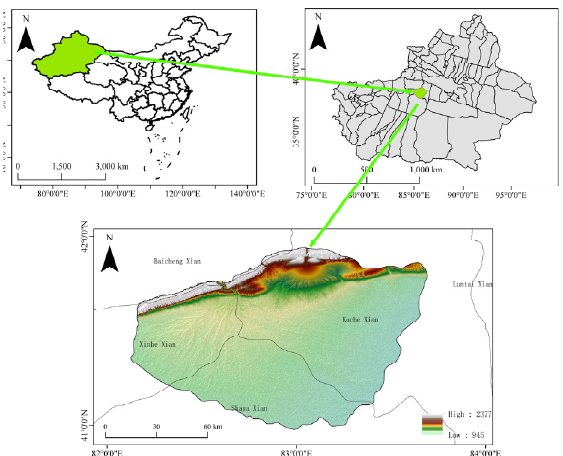
Figure 1. Distribution of sampling points.